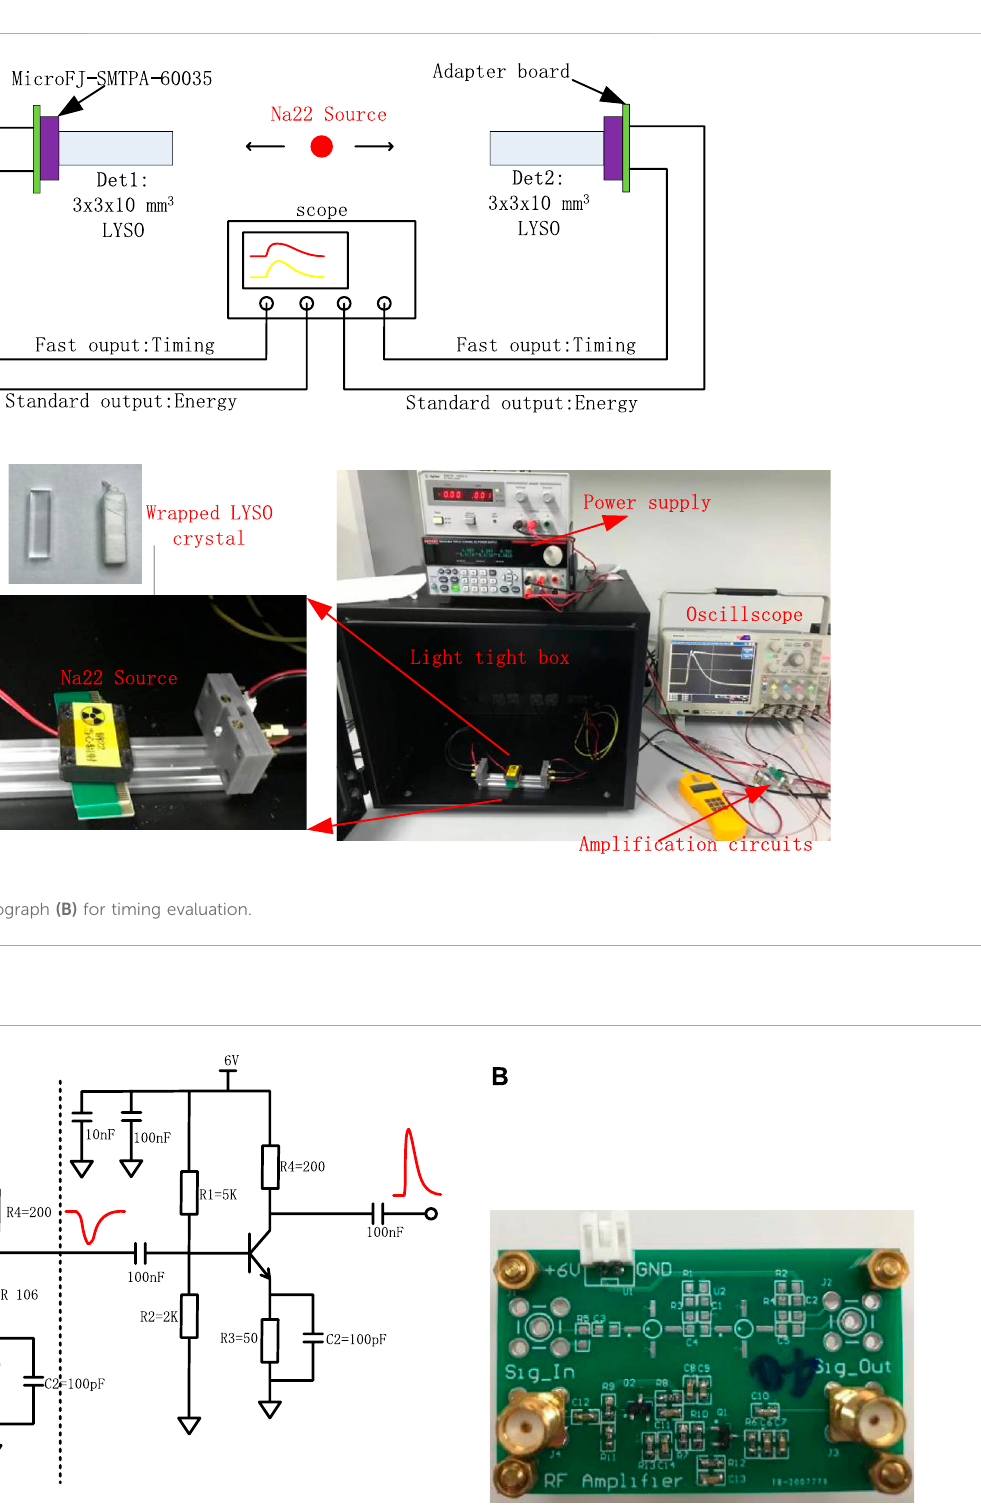
RF ampli fi er needed an external bias resistor. In our experimental setup, the resistor was 150 Ω . After measurements, the overall gain of the two-stage RF ampli fi cation circuit was about 60.